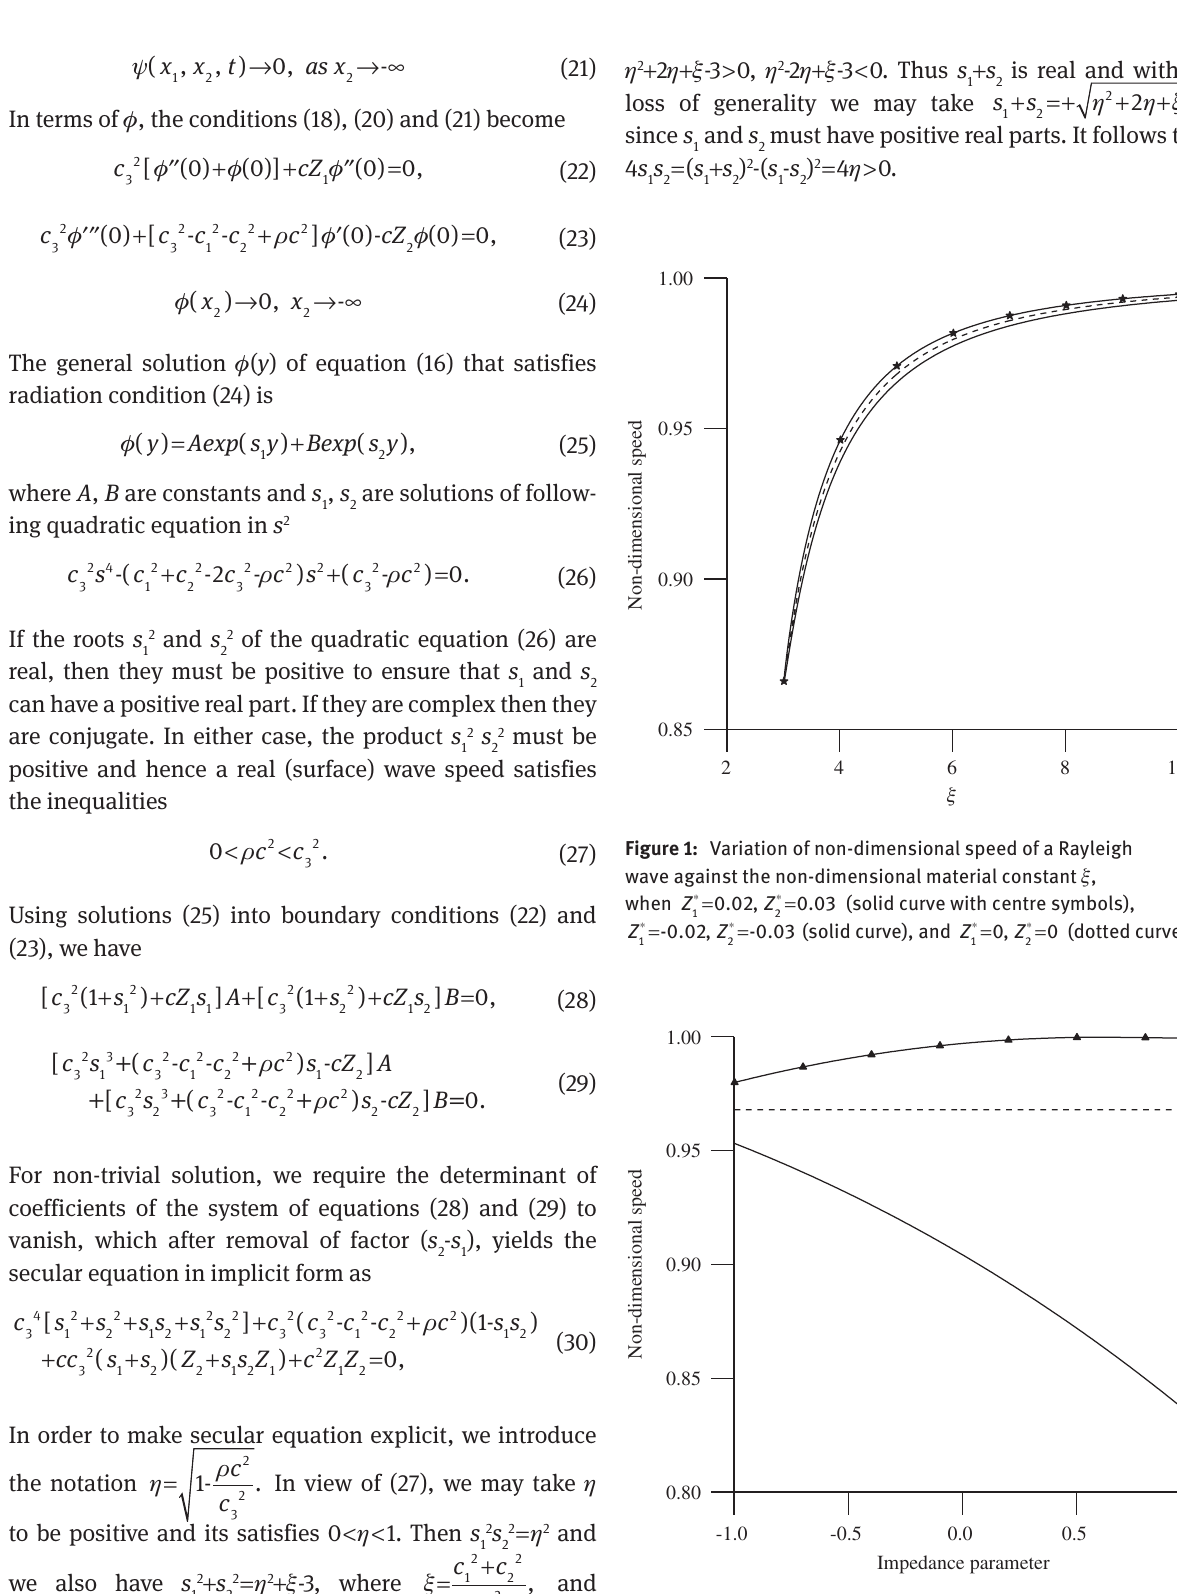
Figure 2: Variation of non-dimensional speed of a Rayleigh wave against an impedance parameter ∗ (solid curve with centre symbols), ∗ = (dotted curve).